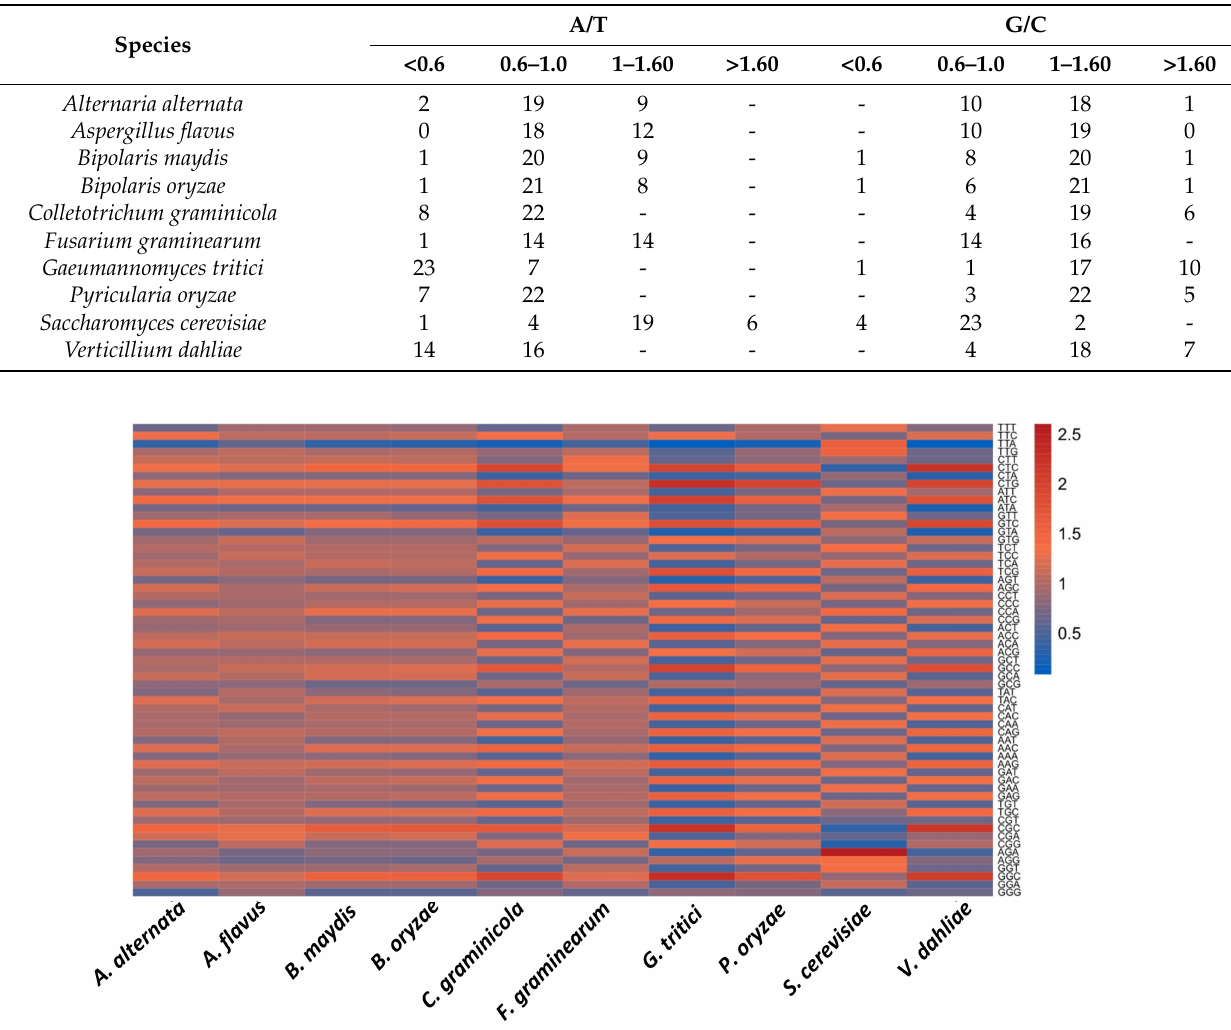
Table 3. Number of A/T- and G/C-rich overrepresented, underrepresented, less frequently used, and more frequently used codons.